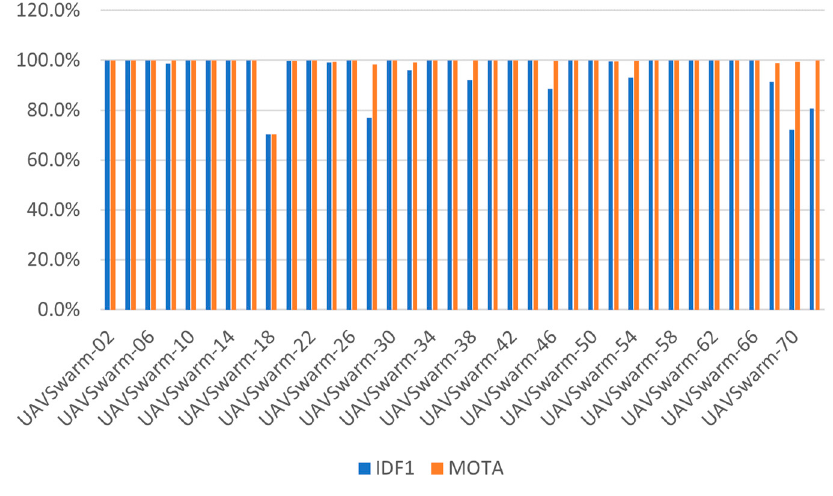
Figure 7. Comparison of IDF1 and MOTA results on the UAVSwarm dataset testing set using GNMOT.